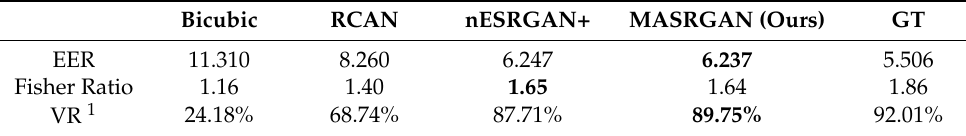
Figure 16. The comparison of ROC curves between nESRGAN+ (current SOTA) and MA-SRGAN (SR/wMsk) on the CelebA dataset. Table 4. The comparison with different resolution in terms of EER and corresponding